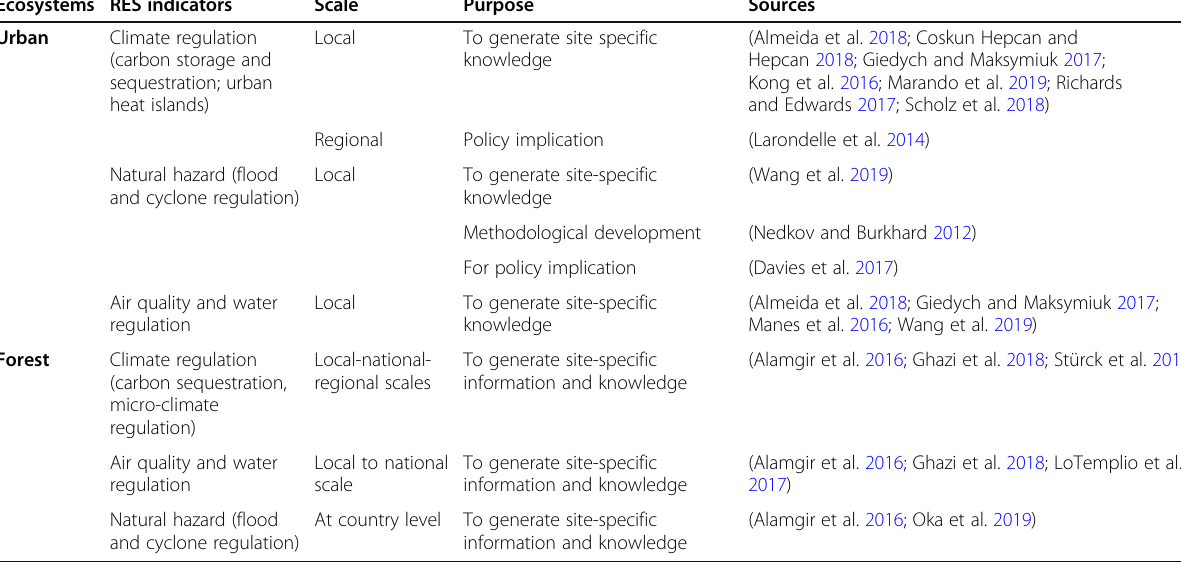
Table 3 Overview of different RES indicators in urban and forest ecosystems studied by the selected papers Ecosystems RES indicators